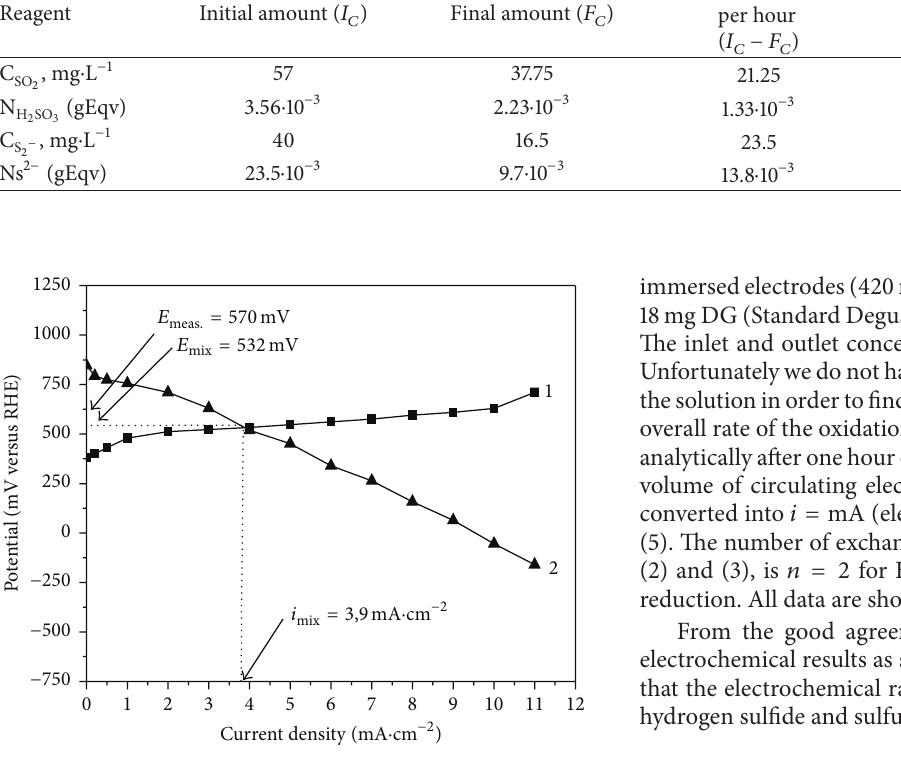
Figure 5: Polarization curves for the oxidation of H 2 S from Figure 2(a) and the reduction of SO 2 from Figure